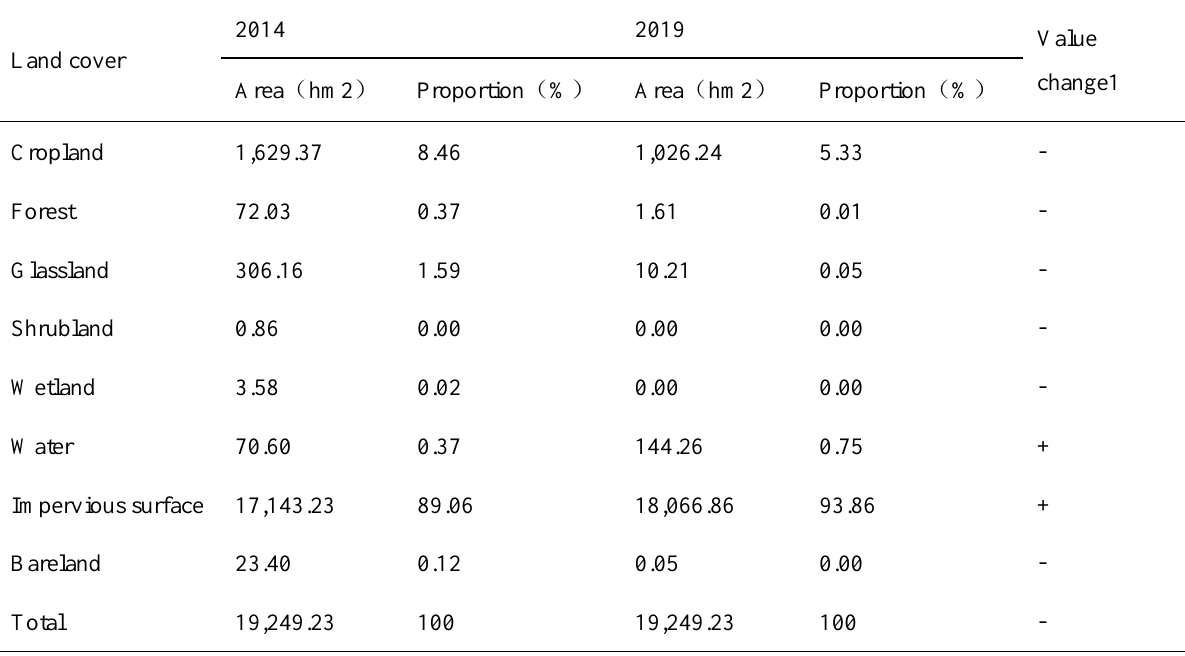
Table 3. Statistics of land cover types in the study